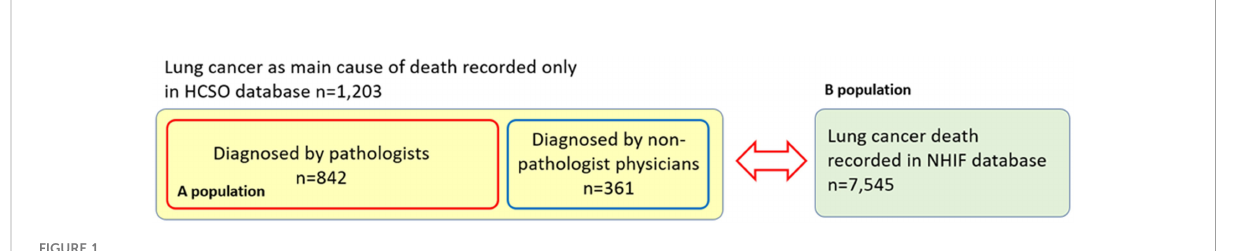
FIGURE 1 Patient populations included in the HULC study. HULC, Hungarian Undiagnosed Lung